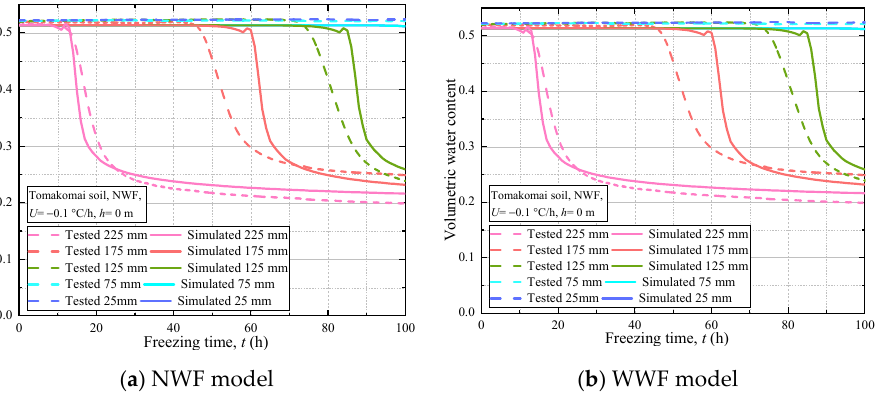
Figure 7. Comparison of the simulated and tested volumetric water content at the different observation points.